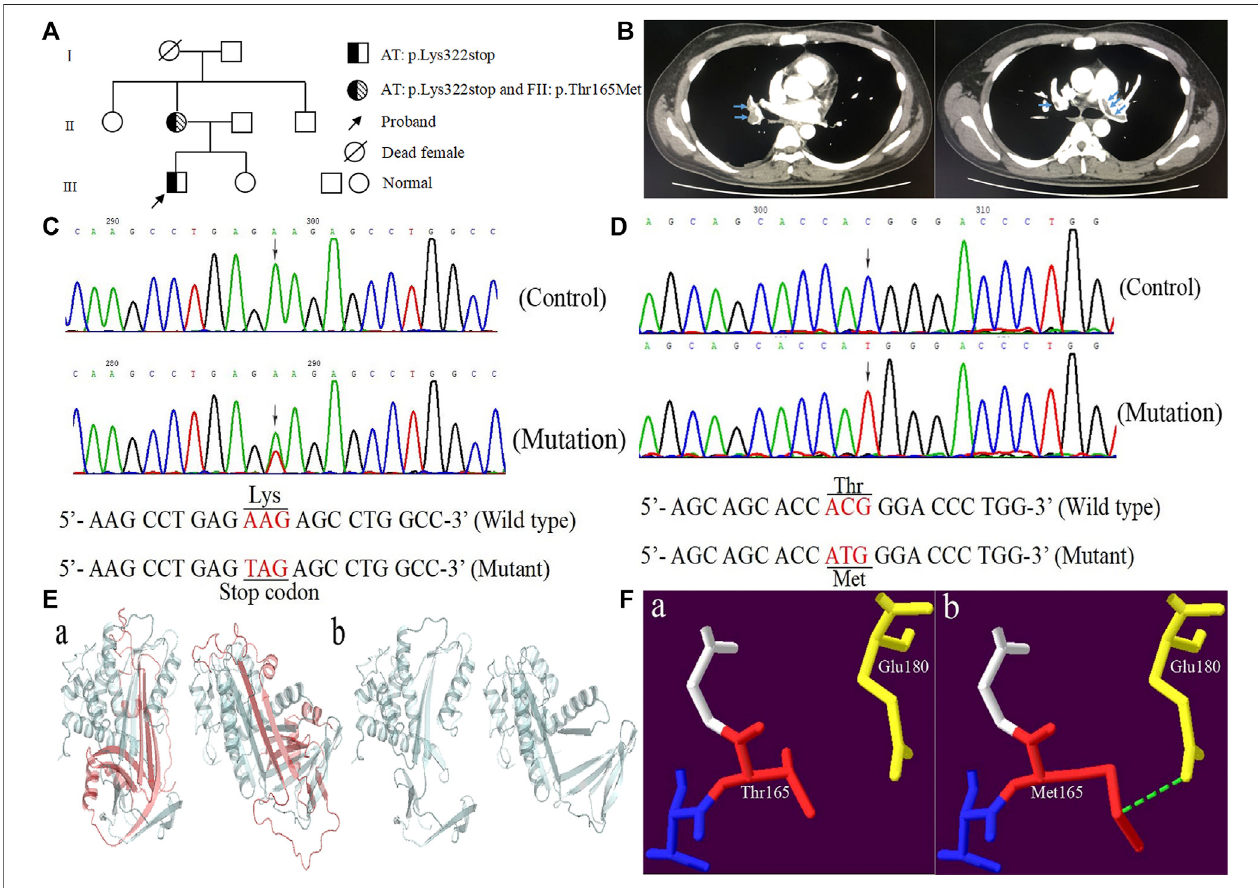
FIGURE 1 | The clinical and genetic data of the proband. (A) Pedigree chart of the family. (B) The computed tomography angiography of the proband. (C) Sequence diagrams of SERPINC1 :p.Lys322stop. (D) Sequence diagrams of F2 :p.Thr165Met. (E, F) Model analysis diagrams: (A, B) AT:p.Lys322stop and (A, B) FII: p.Thr165Met before and after